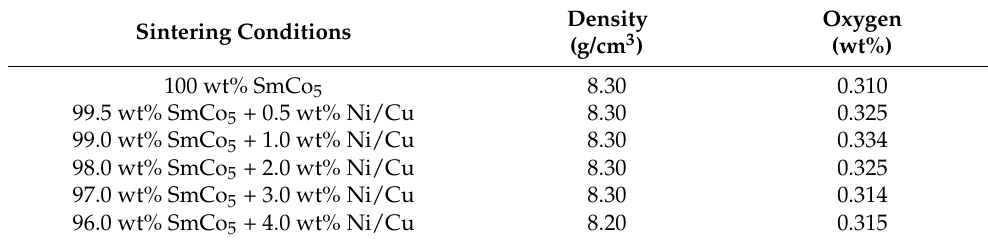
Table 1. Density and oxygen contents of sintered samples of SmCo 5 with 0–4 wt% Ni/Cu.